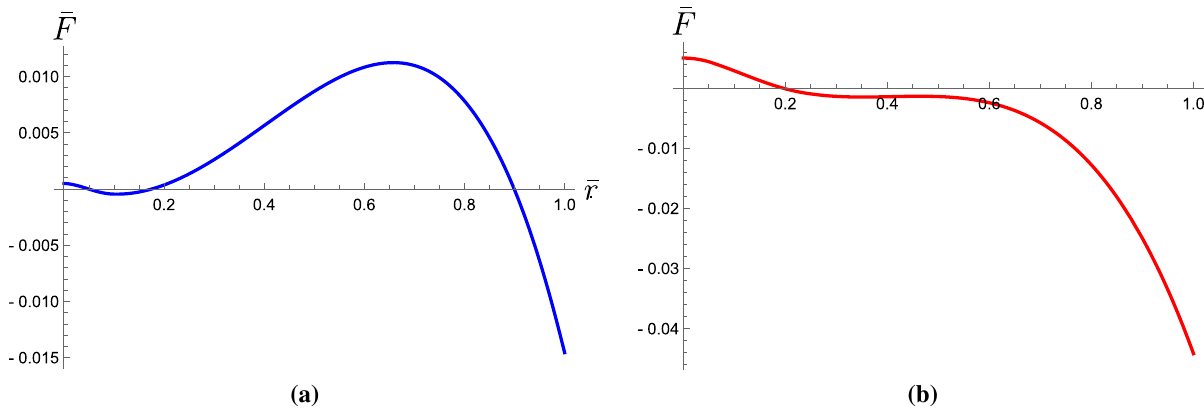
Fig. 7 Free energy is plotted against horizon radius: a ¯ a = 0 . 1 and ¯ α = 0 . 001 and plot b is for ¯ a = 0 . 1, ¯ α = 0 . 01and l =